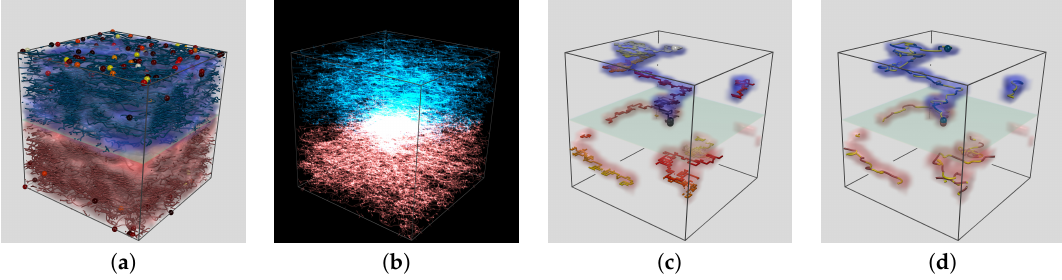
Figure 10. Scenario 1: Simulation evaluation (SE) of the flat morphology with one charge pair. The images show different rendering options for the entire ensemble ( a ) trajectories embedded in a charge coverage volume visualization, trajectories reaching the electrode are displayed as spheres colored by time they need to reach the electrode, ( b ) density projection of trajectories; for one selected trajectory embedded in the charge coverage volume ( c ) original trajectory colored by progression time ( d ) flow line displaying the effective velocity as stripe